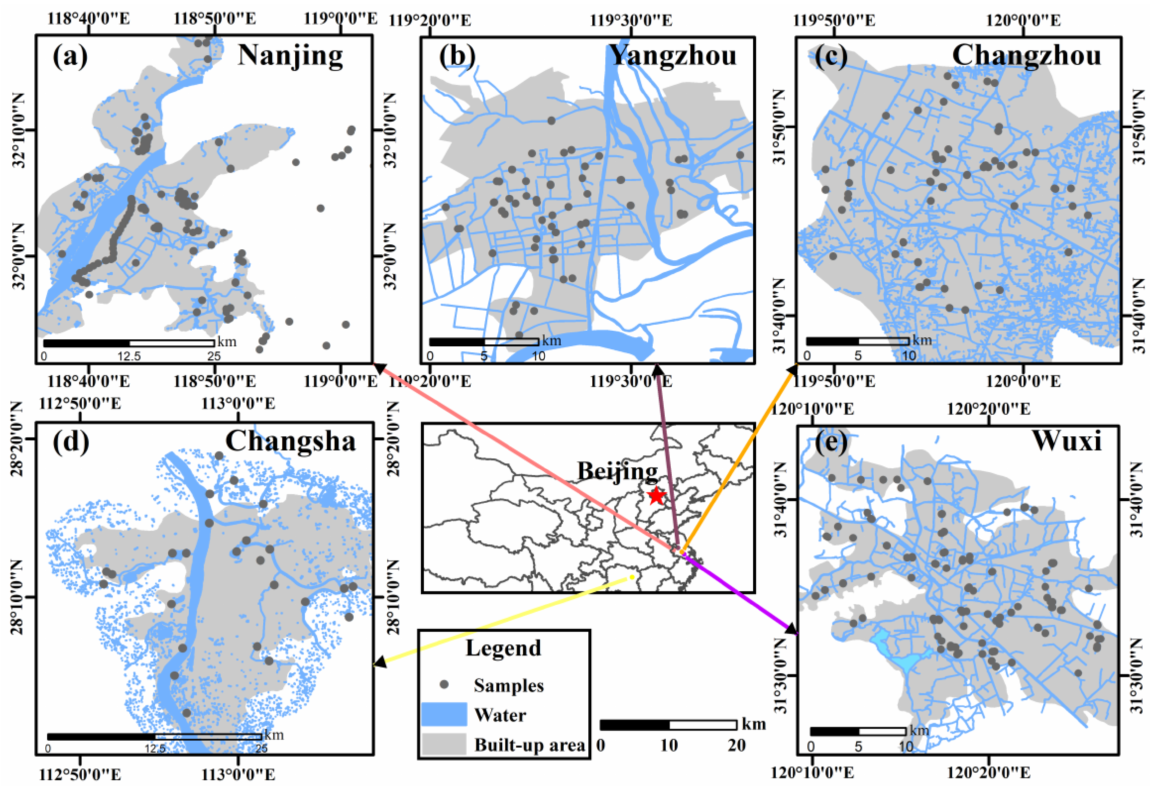
Figure 1. Locations and distributions of sampling points in ( a ) Nanjing, ( b ) Yangzhou, ( c ) Changzhou, ( d ) Changsha, and ( e )